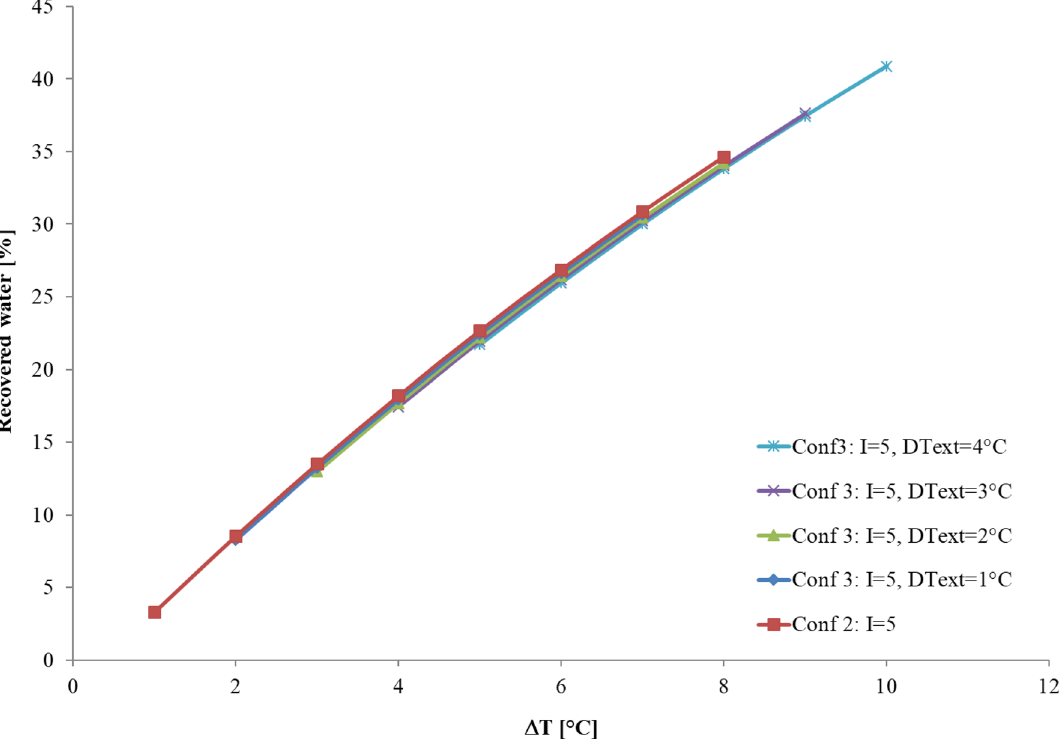
Fig. 9 Recovered water versus ΔT in configuration 3 and configuration 2 at I = 5 at increasing ΔT of the figure). Feed temperature = 45 °C; RH feed =